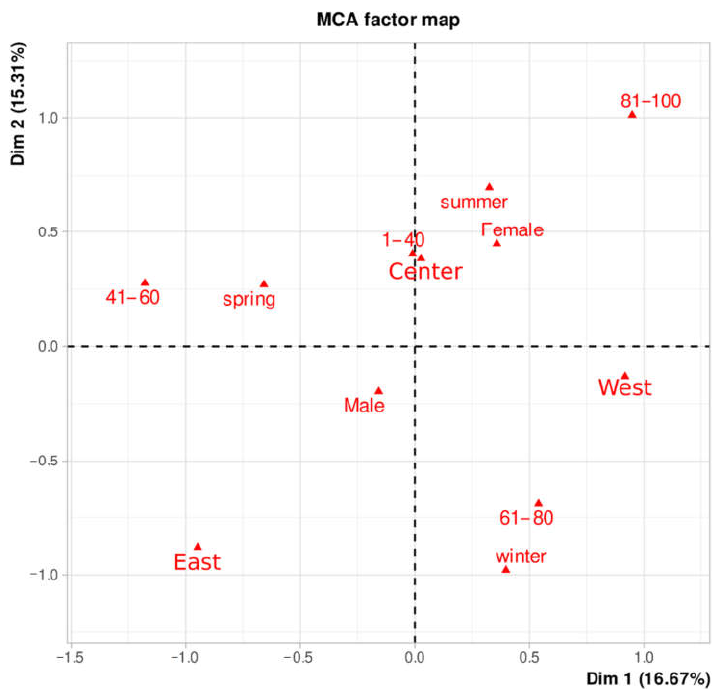
Figure 2. Multiple correspondence analysis describing associations between categories of age, gender, the month of sampling and geographical location of patients with Q fever. The two first principal factors derived from the MCA analysis were retained to plot the coordinates of the studied variables and categories. Factorial axis1 (dimension 1) cap-